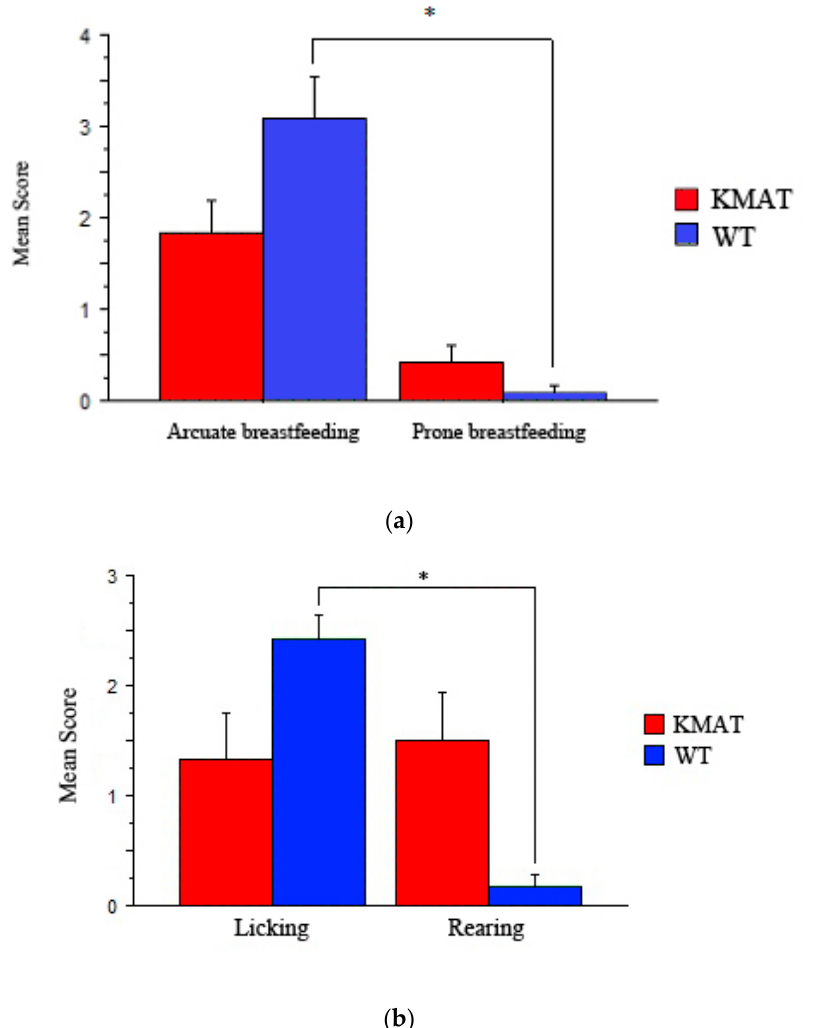
Figure 1. ( a ) Patterns of breastfeeding: formal comparison of arched and prone mode, expressed by mothers of WT and K-MAT epigenotype (n = 12 WT; n = 9 K-MAT). K-MAT rats are MATs (heterozygous offspring of WT dam and KO father) that have been fostered to (and abused by) KO mothers (hence the initial “K”). The asterisk (*) indicates the statistically significant difference between either breastfeeding mode in WTs. The observations of maternal behavior covered a two- week period between postnatal day (PND) 2 and 16. ( b ) Attractors of interest: formal comparison on attention directed towards offspring (licking) or outwards (rearing), expressed in dams of WT and K-MAT epigenotype (n = 12 WT; n = 9 K-MAT). Observations carried out using the ethogram and the methods described in Methods; dams are the same as above ( a ). The asterisk (*) shows the statistically significant difference between the two attractors of interest in the WT mother. As expected, the latter is preferring to take care of her offspring (i.e., licking them) rather than expressing any interest for external attractors. The K-MAT mother, on the contrary, is much more attracted by external environment rather than by caring for her